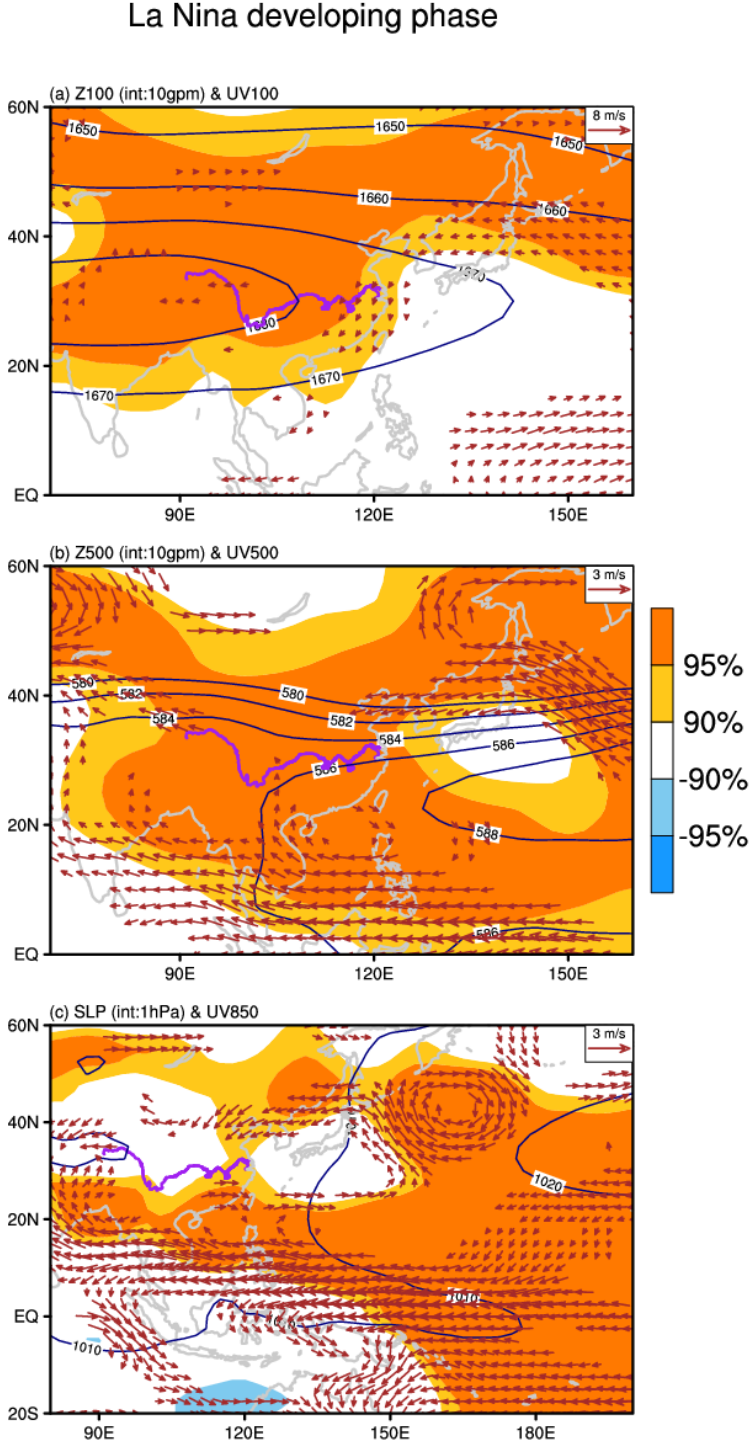
Figure 7. The JJA composite of the 100 hPa and 500 hPa geopotential height fields, sea level pressure (Z200, Z500, and SLP), and wind (UV200, UV500, and UV850) in the CP–La Niña developing phase from 1950 to 2016. The blue contours represent the climatological mean of JJA Z200, Z500, and SLP plus the corresponding anomalies, that is, the real condition. The shadings indicate the areas beyond 95% and 90% confidence level based on a Student’s t -test). Arrows denote the UV200, UV500, and UV850, and only those data points statistically significant over the 90% confidence level are